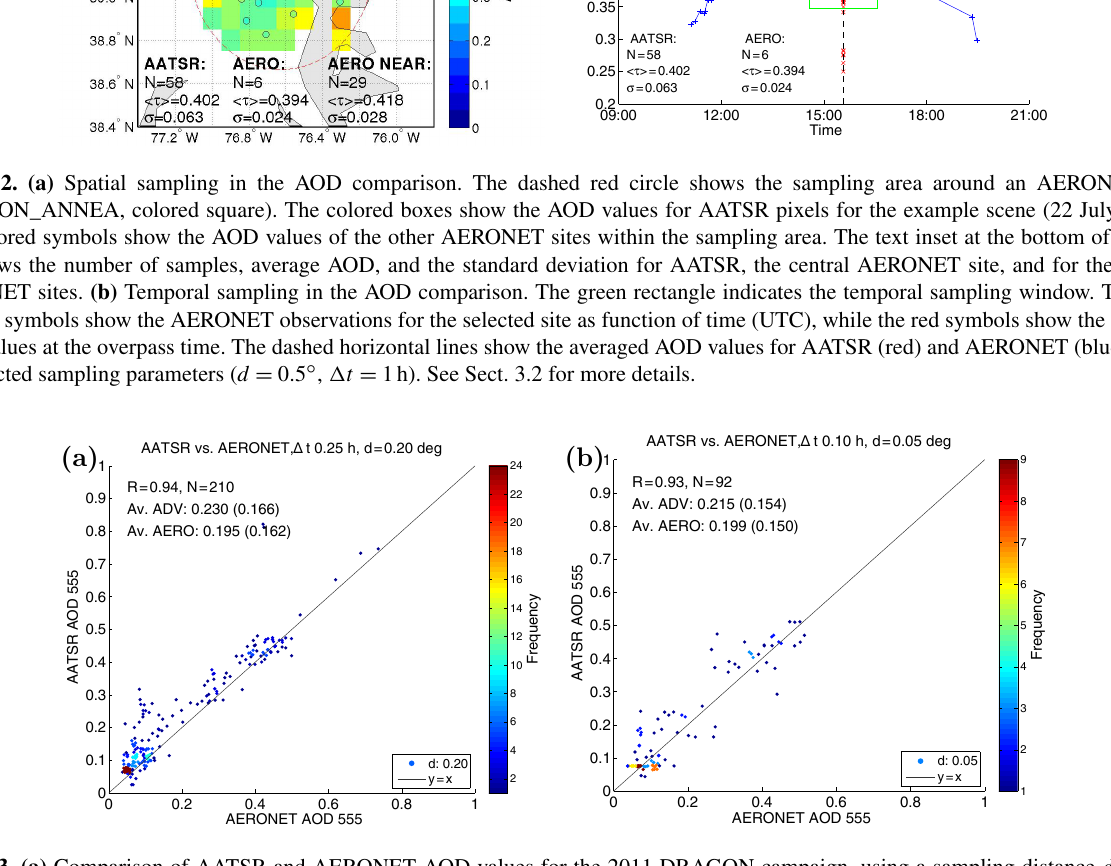
Figure 3. (a) Comparison of AATSR and AERONET AOD values for the 2011 DRAGON campaign, using a sampling distance d = 0 . 2 ◦ and a time window (cid:49)t = 0 . 25h. (b) Comparison with d = 0 . 05 ◦ and a time window (cid:49)t = 0 . 1h, corresponding to closest point comparison. The text insets show the correlation coefficient R , number of matches N , and average AOD values (standard